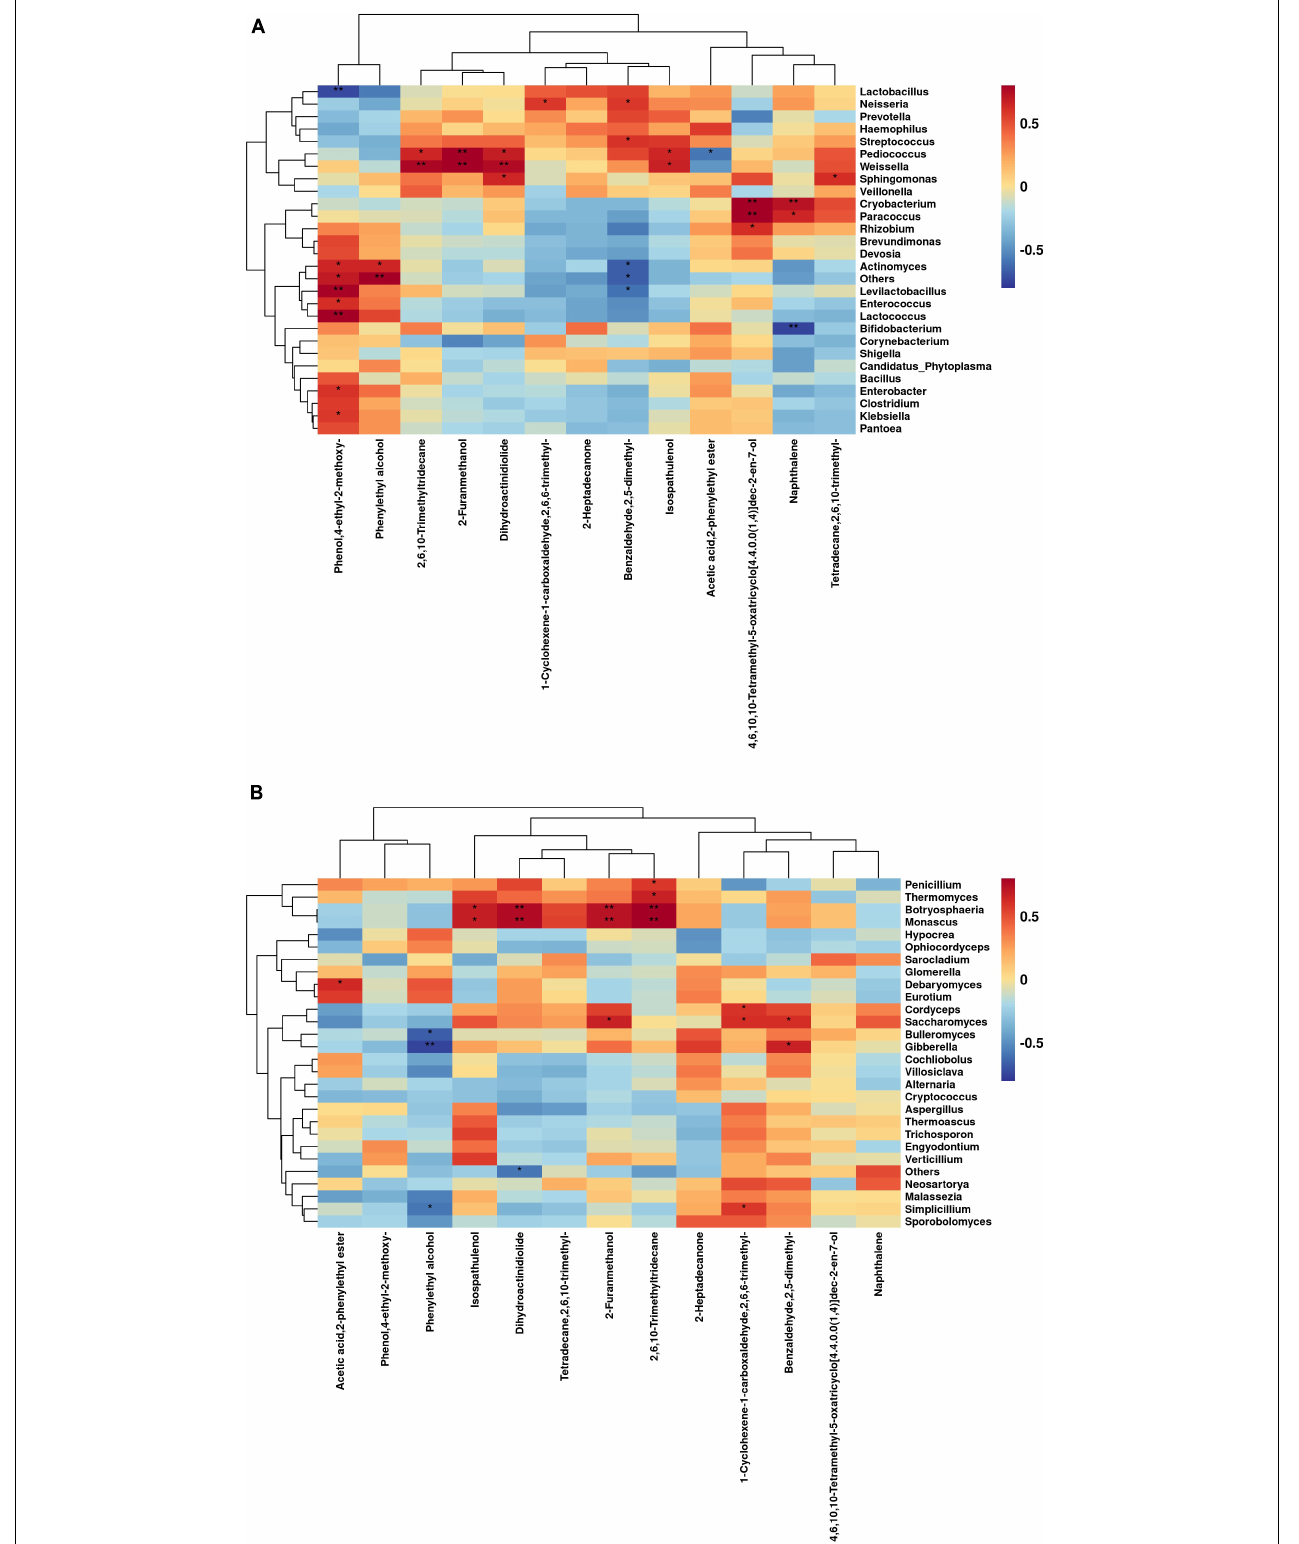
FIGURE 6 | Correlation of bacterial (A) and fungal (B) genus levels with volatile chemicals during aerobic exposure of silage (* P < 0.05; ** P < 0.01).